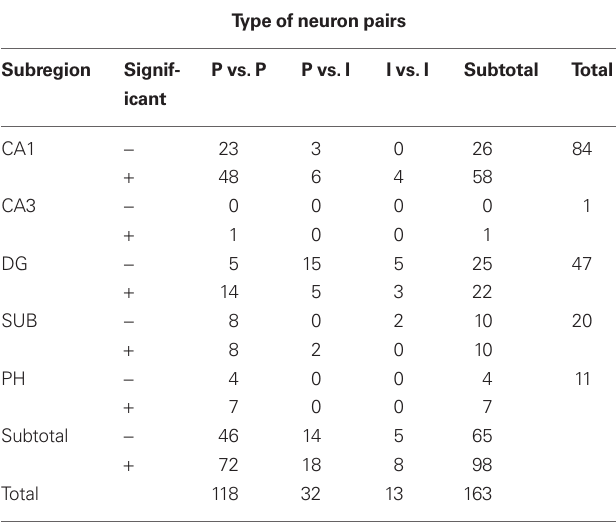
Table 1 | Number of neuron pairs showing significant and non-significant cross-correlograms (CCgs) in each subregion of the HF and PH.